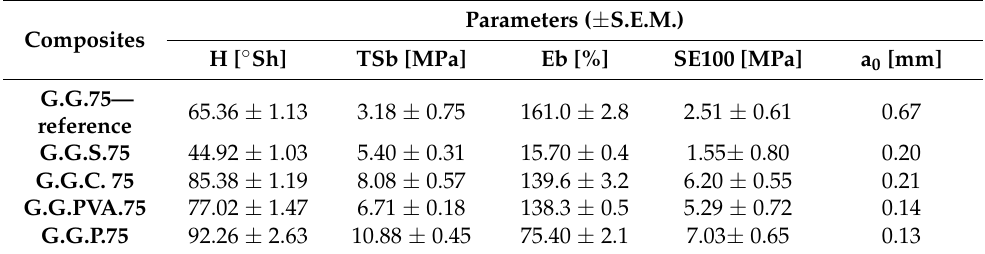
Table 5. Mechanical properties of the composites with different types of